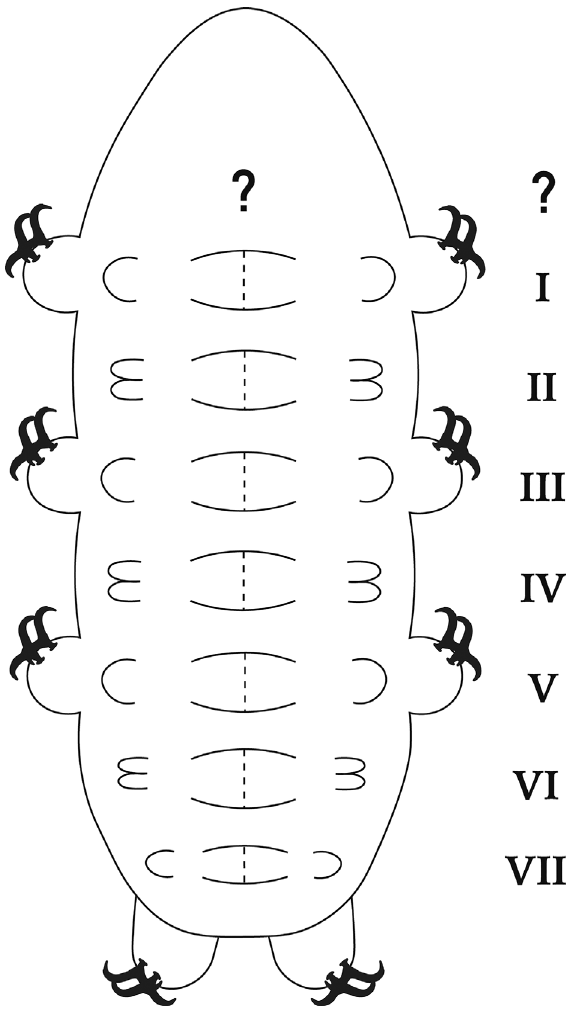
Figure 1. Schematic drawing showing the gibbosity shape and arrangement. The question marks indicate the doubt about presence or absence of a very first medial gibbosity. Roman numbers indicate the row numbers of the surely present